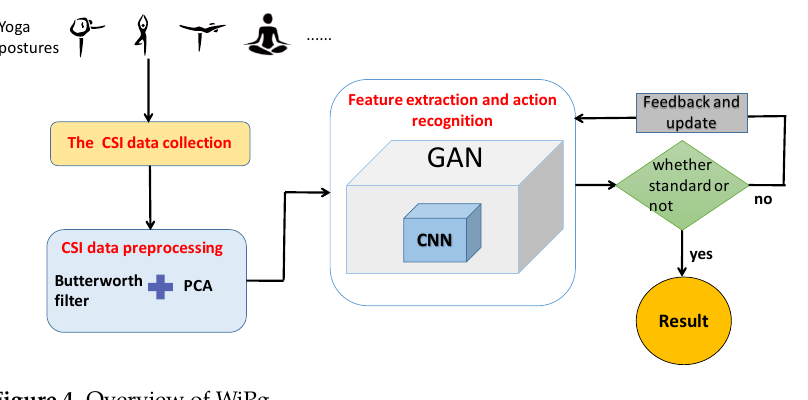
Figure 4. Overview of WiPg.